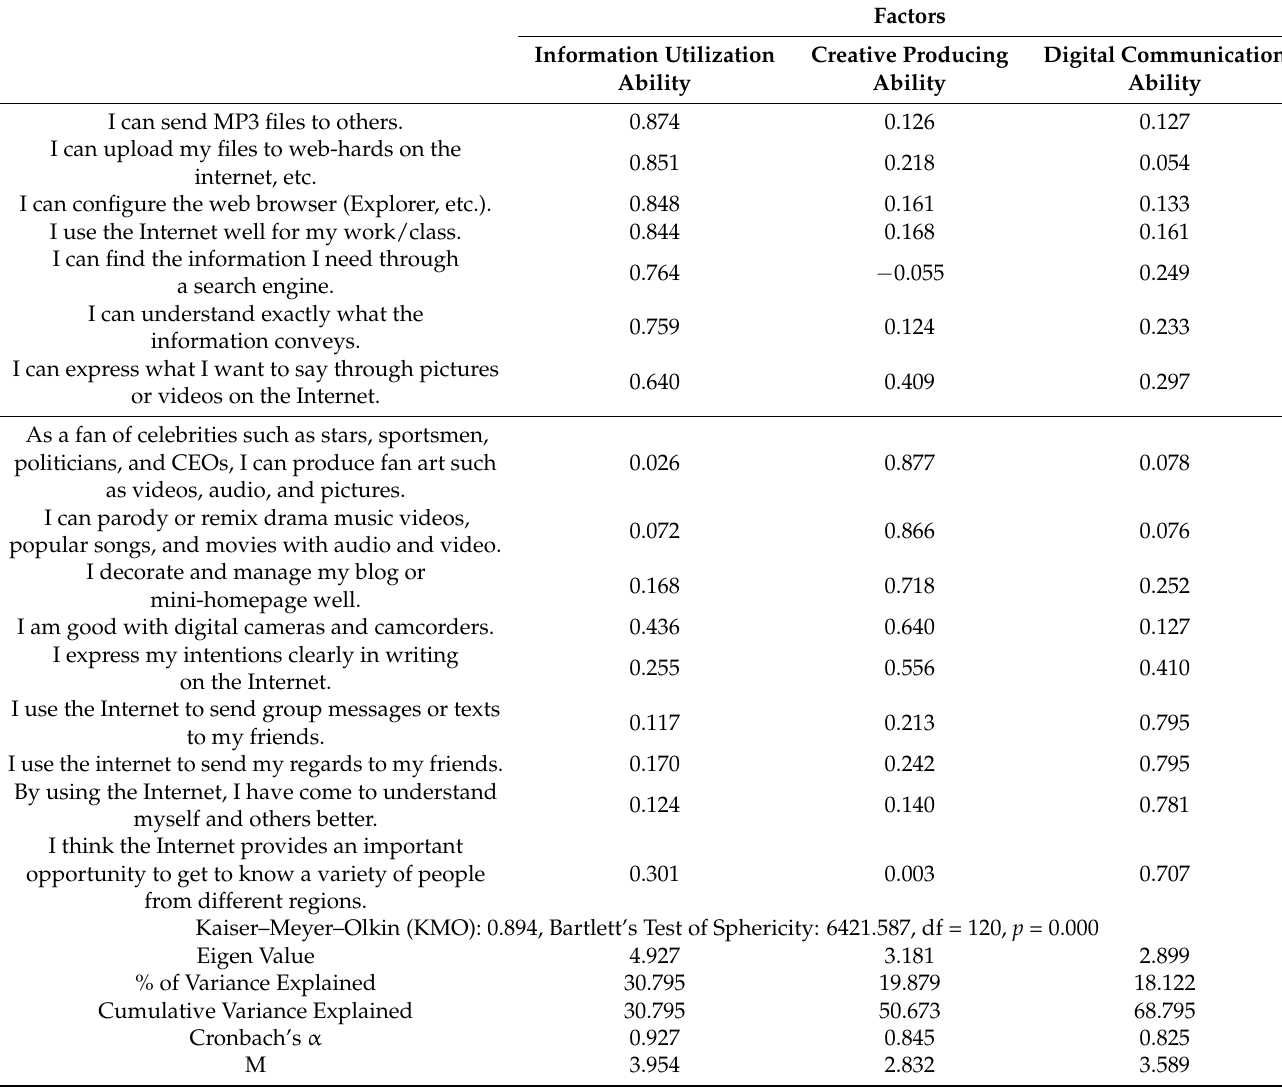
Table 2. The result of exploratory factor analysis: digital